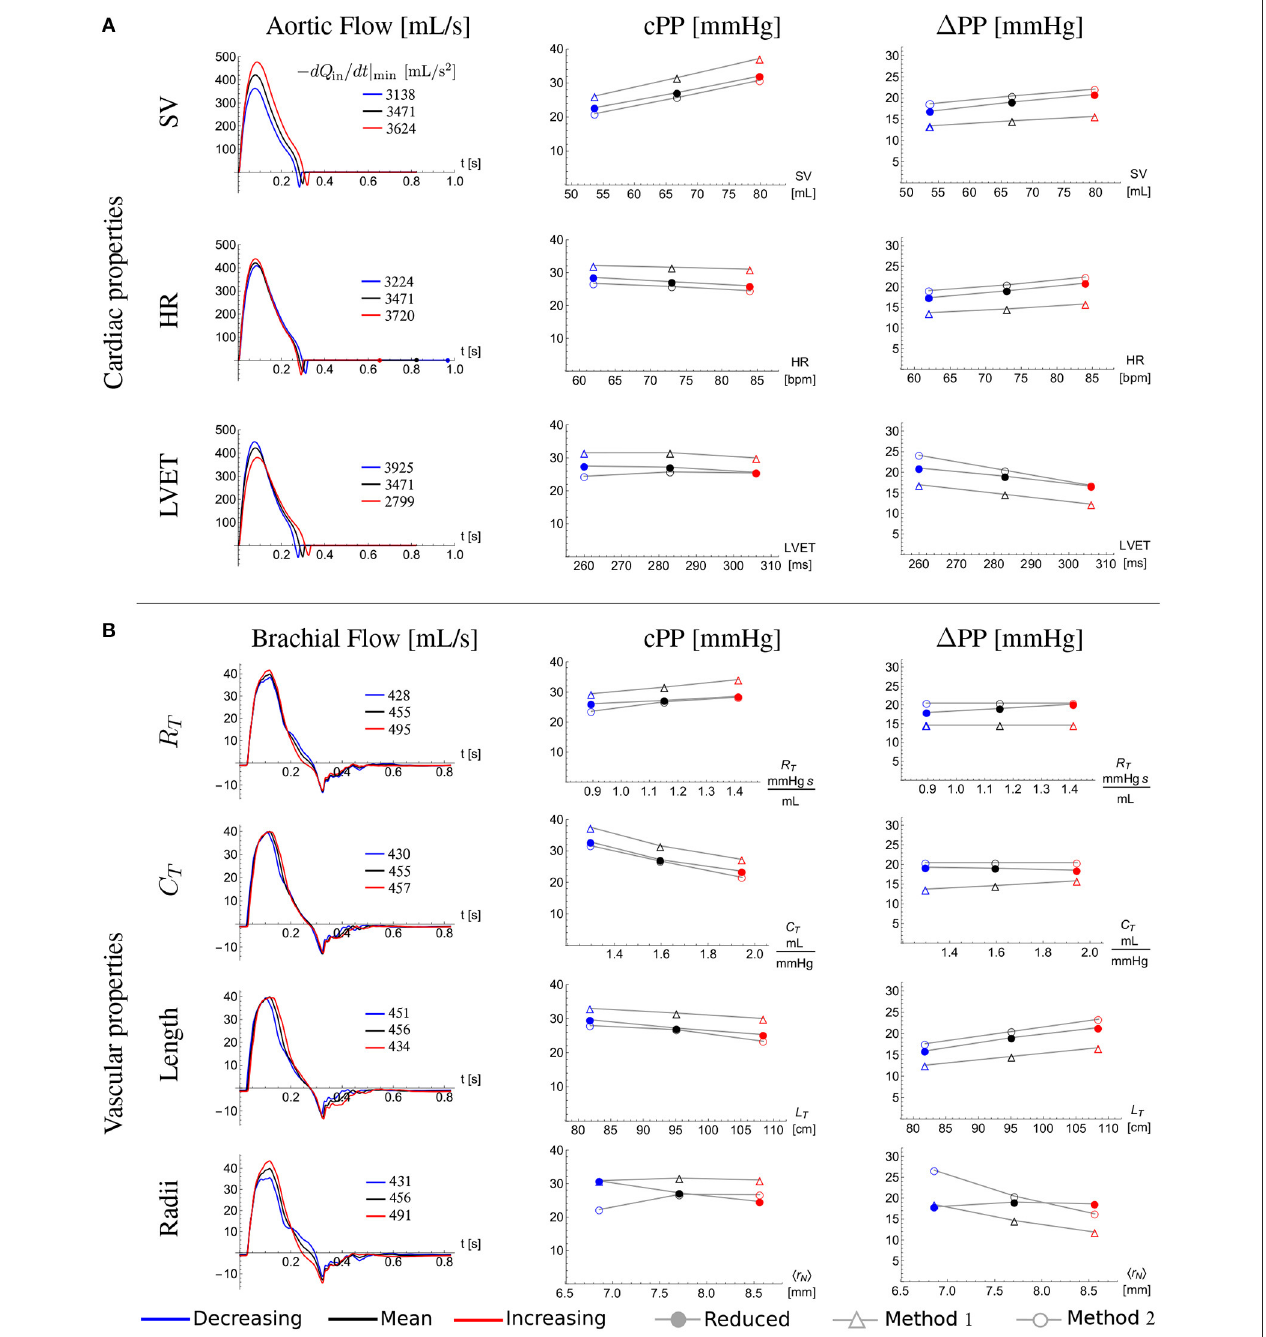
FIGURE 7 | Effect of cardiovascular properties on central pulse pressure, cPP, and its amplification from the aortic root to the outlet of the brachial artery, 1 PP. Aortic root (A) and brachial artery (B) flow wave (first column), cPP (second column), and 1 PP (third column) for the 25-year-old baseline subject (black) and with a standard deviation (SD) decrease (blue) and a SD increase (red) in (A) stroke volume (SV), heart rate (HR) and left ventricular ejection time (LVET), and (B) total vascular resistance ( R T ) and total vascular compliance ( C T ); and with a 14 % decrease (blue) and 14 % increase (red) in the total network length ( L T ) and with a 11 % decrease (blue) and 11 % increase (red) in the average radius of the network ( h r N i ). The closed dots were calculated using the reduced model, the open triangles were calculated using Equation (12) of Method 1 and the open dots were calculated using Equation (15) of Method 2. Legends in the first column indicate the maximum temporal rate of decrease in late systolic-flow in mL/s 2 for all flow waves.